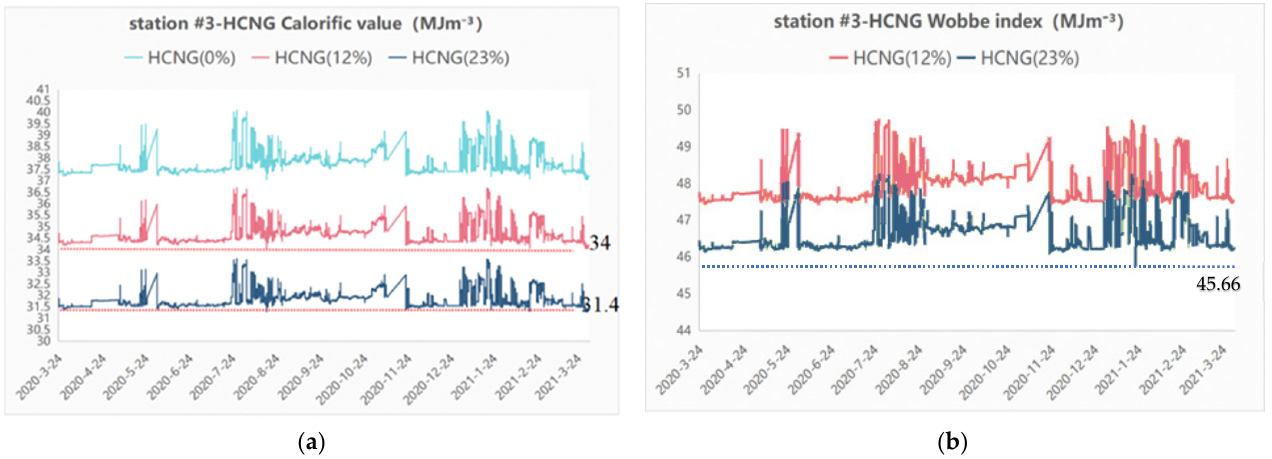
Figure 5. ( a ) Calorific value of natural gas source station #3 measured between 2020.3 and 2021.3 . ( b ) Wobbe Index of natural gas source station #3 measured between 2020.3 and 2021.3. The light blue line in Figure 6a is the real calorific value of gas source station #4. The